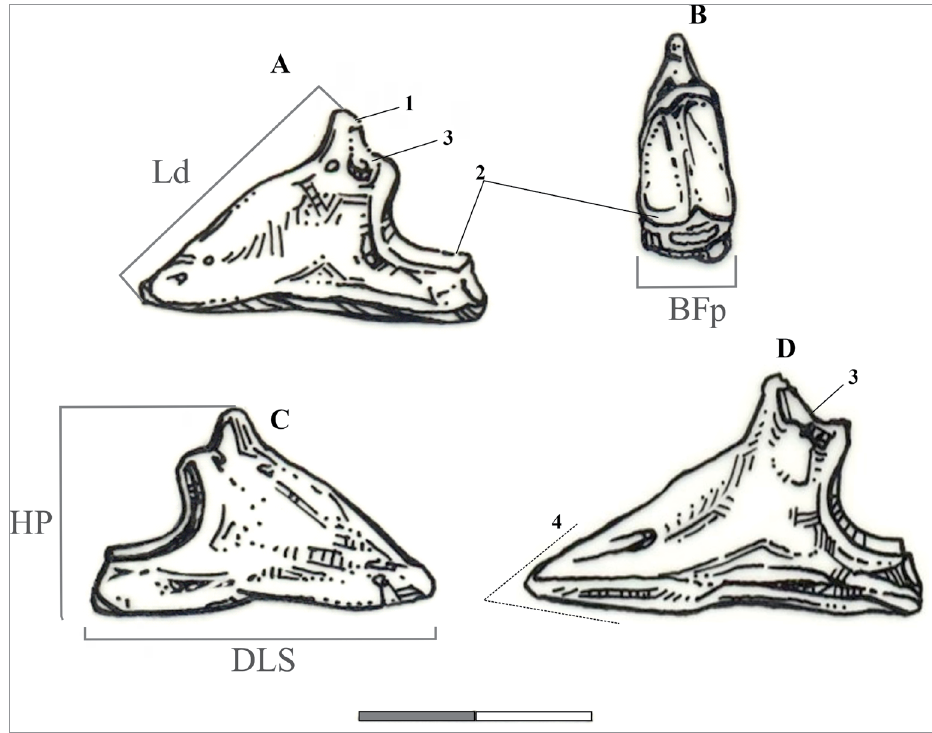
Illustrations: Estie Rossouw, with the light coming from the top left-hand corner Scale = each scale bar represents 10 mm Figure 2: (A) A. m. marsupialis , p. distalis manus, axial view; Ld = length of dorsal surface. (B) A. m. marsupialis , p. distalis manus, proximal view; BFp = (greatest) breadth of the proximal articular surface. (C) A. m. marsupialis , p. distalis manus, abaxial view; HP = height in the region of the extensor process and DLS = (greatest) diagonal length of sole. (D) A. m. hofmeyri , p. distalis manus, axial view; 1= extensor process, 2 = horizontal and posteriorly extended proximal articular surface, 3 = dorsal to palmar (manus) / dorsal to plantar (pedis)